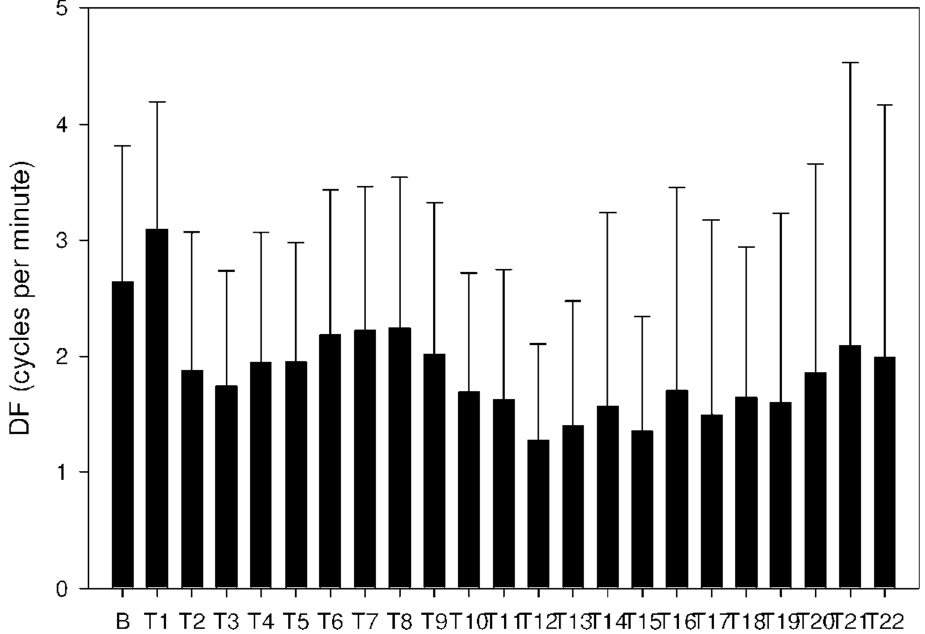
Figure 9. Electrogastrography. Dominant frequency after a single intragastric dose of donepezil (10 mg; group